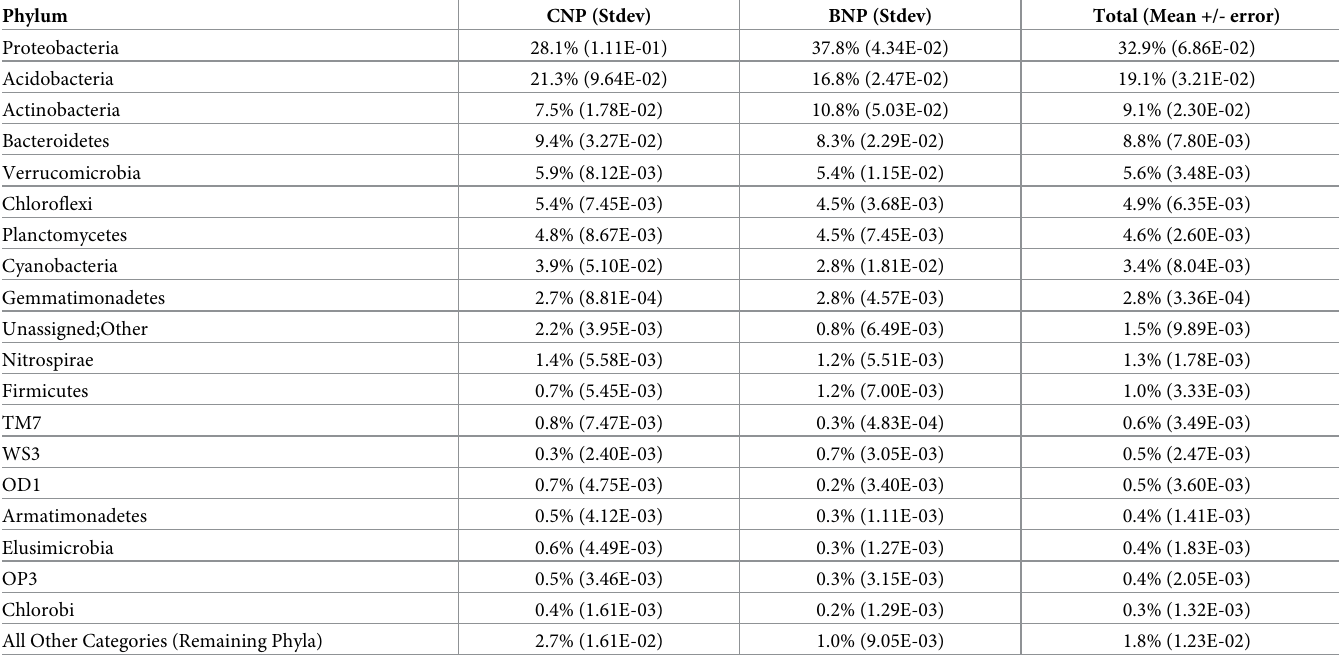
Table 2. Relative abundance of microbiota composition of soil samples collected at two protected areas (all sites n = 8; CNP, n = 3; BNP, n = 5) within TAL.